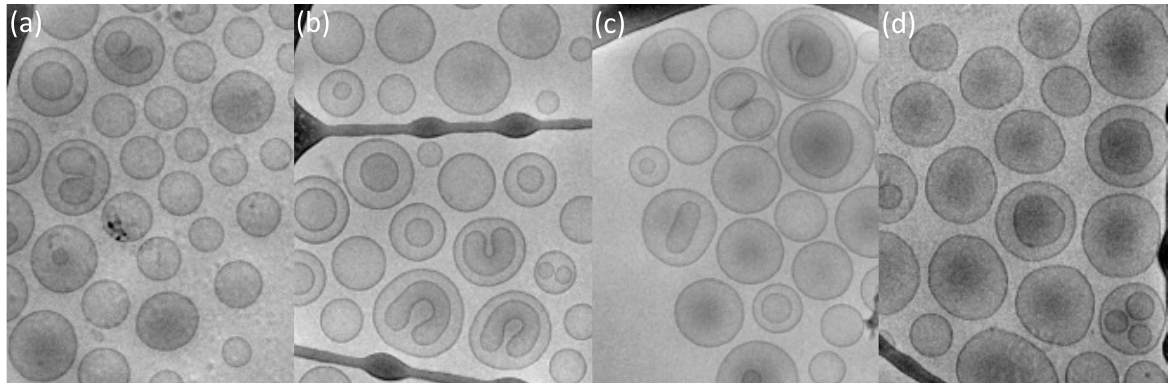
Figure 6. Cryo-TEM images of the produced manganese-loaded NLS and SLL liposomes. LP-NLS-